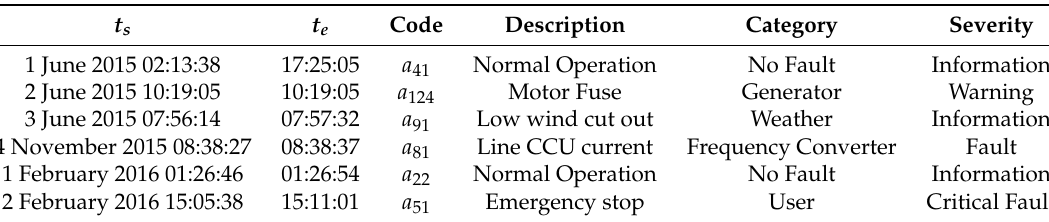
Table 2. Random sample of alarms data from Turbine 2.